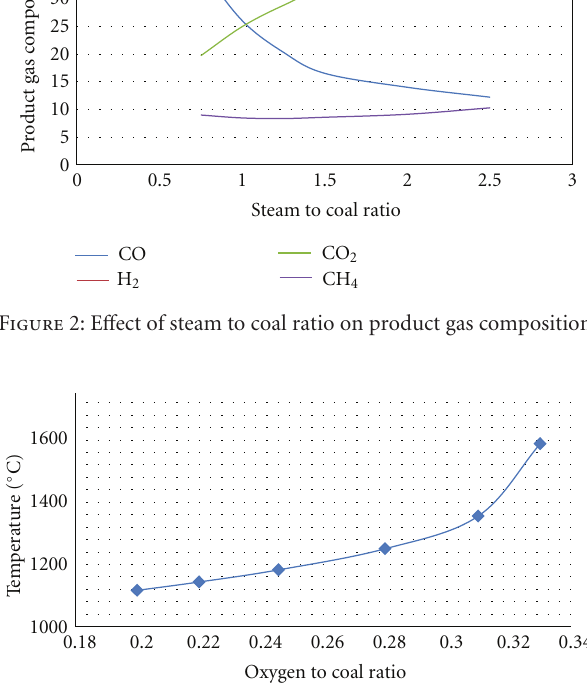
Figure 3: E ff ect of oxygen to coal ratio on gasifier